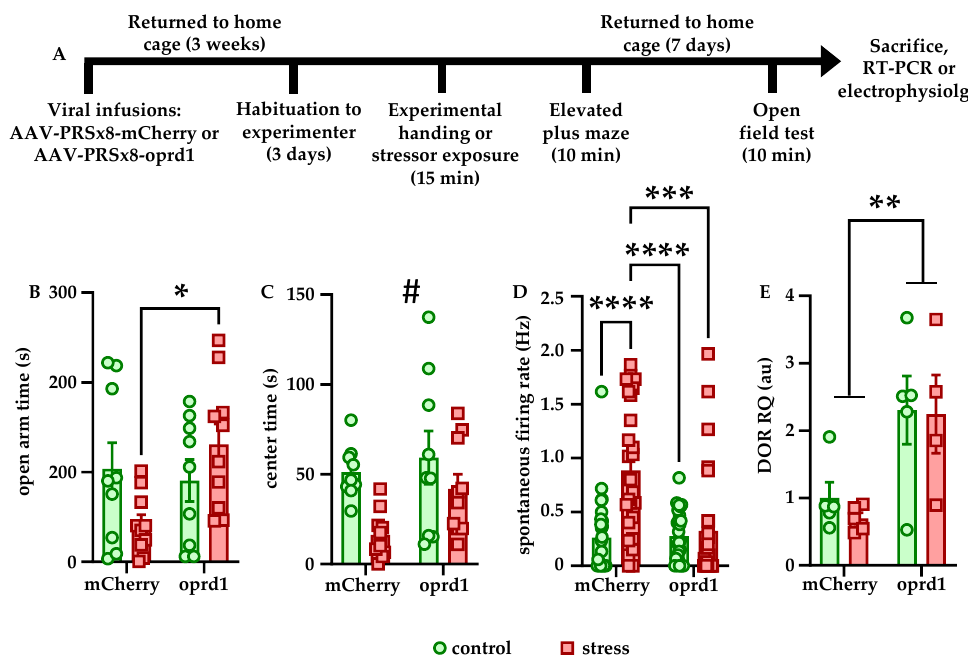
Figure 2. LC-specific DOR overexpression blocks the effects of stress on anxiety-like behavior and LC firing. The experimental timeline is shown in ( A ). Rats were habituated to handling by the experimenter for 3 days but were naïve to the behavioral apparatus when testing began. Stressed rats overexpressing DORs in LC spent significantly more time in the open arms of the EPM than stressed rats expressing mCherry in LC ( B ). One week after stressor exposure, stressed rats spent significantly less time in the center of the OFT, but this effect was more prominent in rats expressing mCherry than rats overexpressing DORs in LC ( C ). Within the mCherry group, stress significantly increased LC firing rate. In addition, LC neurons from stressed mCherry rats fired significantly faster than those from control or stressed DOR-overexpressing rats ( D ). DOR overexpression was validated using RT-PCR ( E ). * p < 0.05; ** p < 0.01; *** p < 0.001; **** p < 0.0001; # main effect of stress, p =